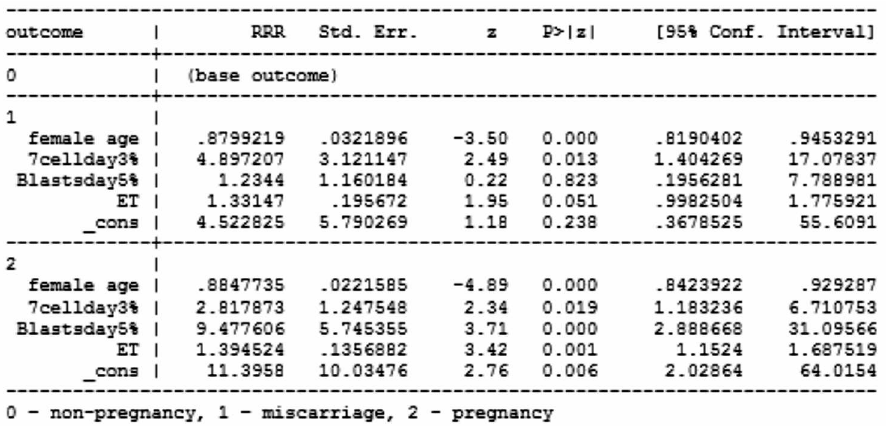
Table 3. The multinomial regression model built on the basis of